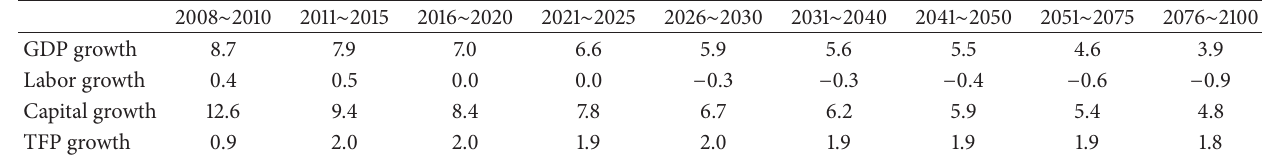
Table 1: Economic growth under the BAU scenario in 2008–2100 (unit: %).